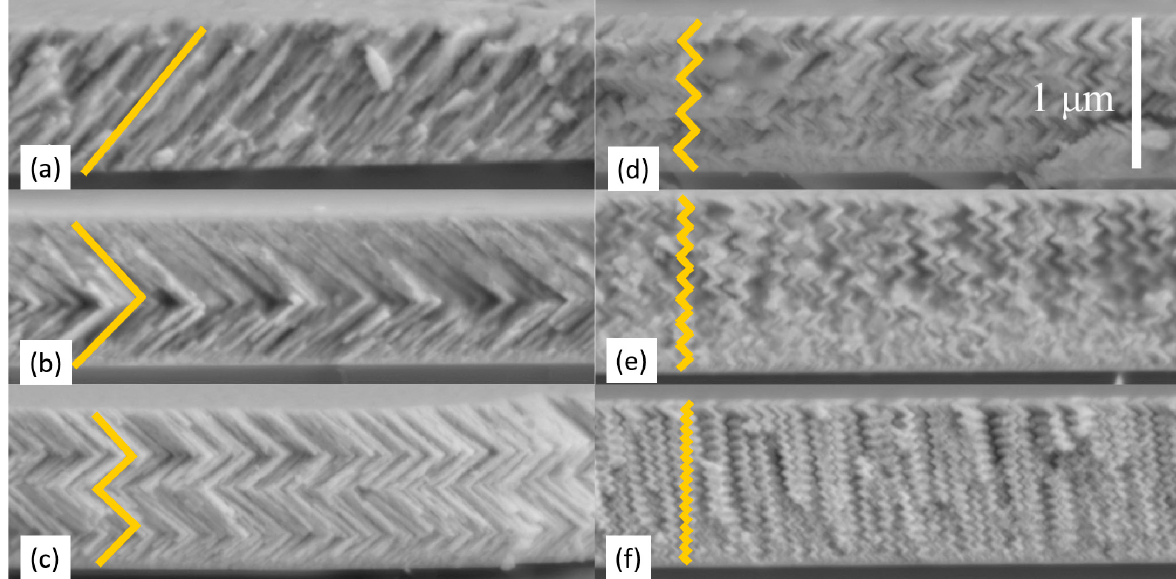
Figure 2. Cross-section views of WO 3 thin films 1 µ m thick exhibiting a zigzag structure. Films were sputter-deposited on (100) Si wafer with a tilt angle α = 80 ◦ and a duty cycle dc = 80% of the pulsing period P . The number of zigzags N was systematically increased: ( a ) 1/2, ( b ) 1, ( c ) 2, ( d ) 4, ( e ) 8, and ( f ) 16. The scale is the same for all pictures.